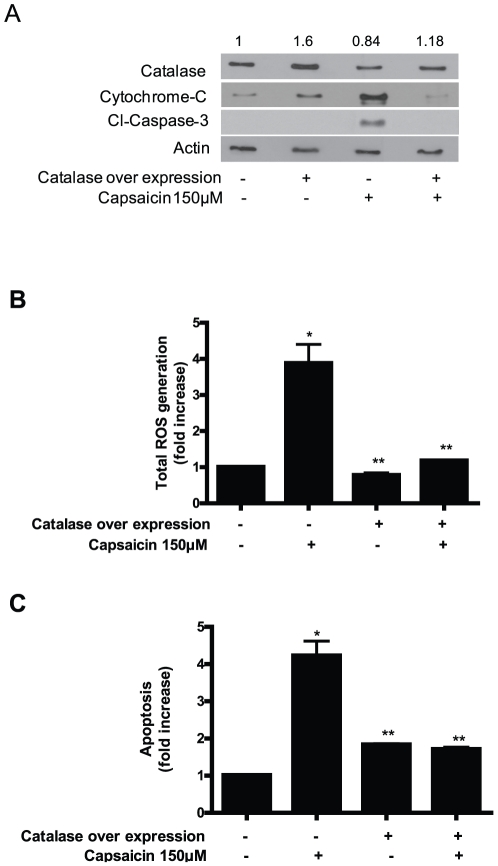
Catalase overexpression protect the cells from capsaicin mediated ROS generation and apoptosis.(A) BxPC-3 cells were transiently transfected with catalase expressing plasmid for 24 h followed by treatment with DMSO or 150 µM capsaicin for another 24 h and the expression of catalase, cytochrome-c and Cl-caspase-3 were evaluated by immunoblotting. Each blot was stripped and reprobed with anti-actin antibody to ensure equal protein loading. These experiments were performed two times independently with similar observations made in each experiment. (B) ROS and (C) apoptosis assay were determined in catalase tranfected BxPC-3 cells followed by treatment with or without 150 µM capsaicin for 24 h. Results are expressed as mean ± SD (n = 3) of three independent experiments. *Statistically different when compared with control (P<0.05) or **statistically different when compared with capsaicin treatment alone (P<0.05), as analyzed by one-way ANOVA followed by Bonferroni's post-hoc test.